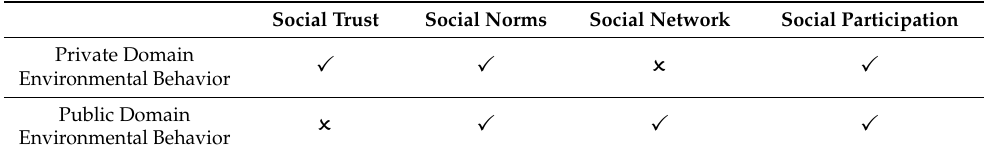
Table 6. Differences in social capital influence.